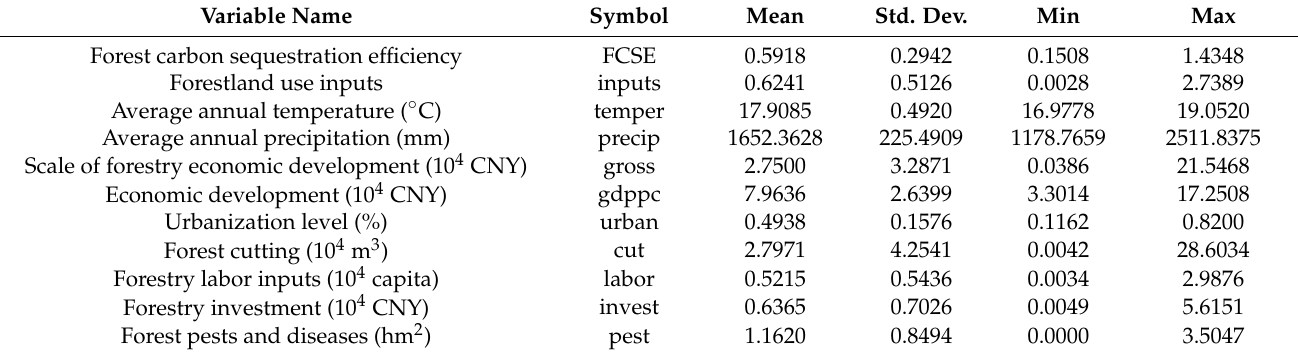
Table 1. Descriptive statistical analysis of the possible influence factors of forest carbon sequestra- tion